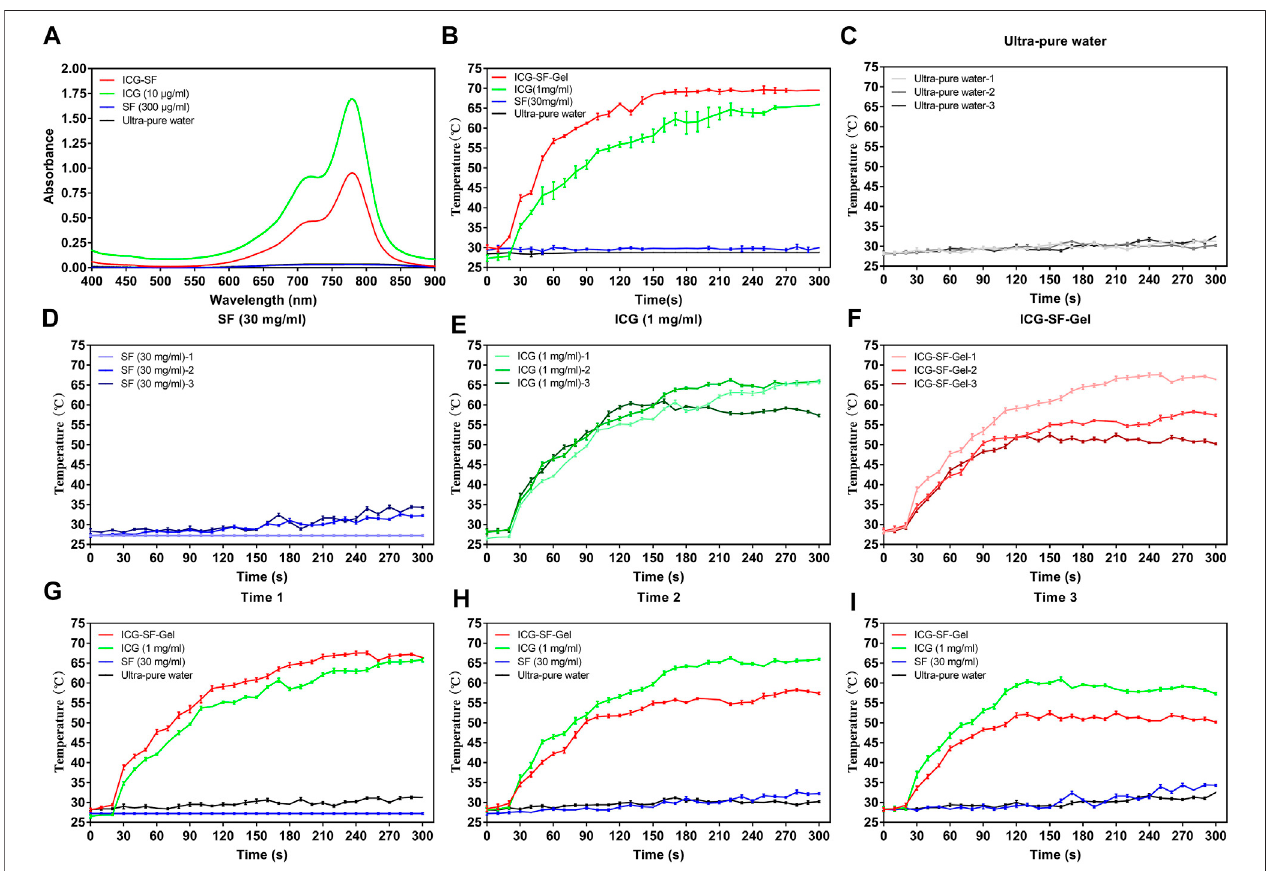
FIGURE 2 | The photothermal effect of ICG and ICG-SF-Gel in vitro . (A) The ultraviolet-visible spectrum of the ICG-SF, ICG, SF, and Ultra-pure water; (B) The temperature change of ICG-SF-Gel, ICG, SF and Ultra-pure water under continuous 808 nm NIR laser irradiation (1 W/cm 2 ) for 300 s; (C – F) Temperature change of Ultra-pure water (C) , SF (D) , ICG (E) and ICG-SF-Gel (F) under the discontinuous 808 nm NIR irradiation mode (ON (cid:2) 5 min, OFF (cid:2) 30 min, three cycles, 1 W/cm 2 ) for 300 s; (G – I) Three cycles temperature change of Ultra-pure water, SF, ICG and ICG-SF-Gel under the discontinuous 808 nm NIR irradiation mode (ON (cid:2) 5 min, OFF (cid:2) 30 min, 1 W/cm 2 ) for 300